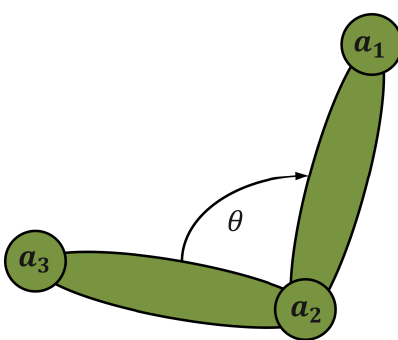
Figure 5. The schematic diagram of the key points.